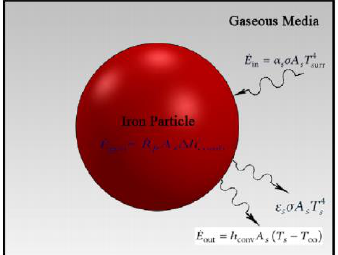
Fig. 1. Schematic of combusted iron particle in gaseous media (Hatami et al